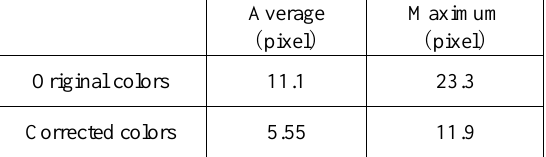
Table 1. Comparison of differences of colors